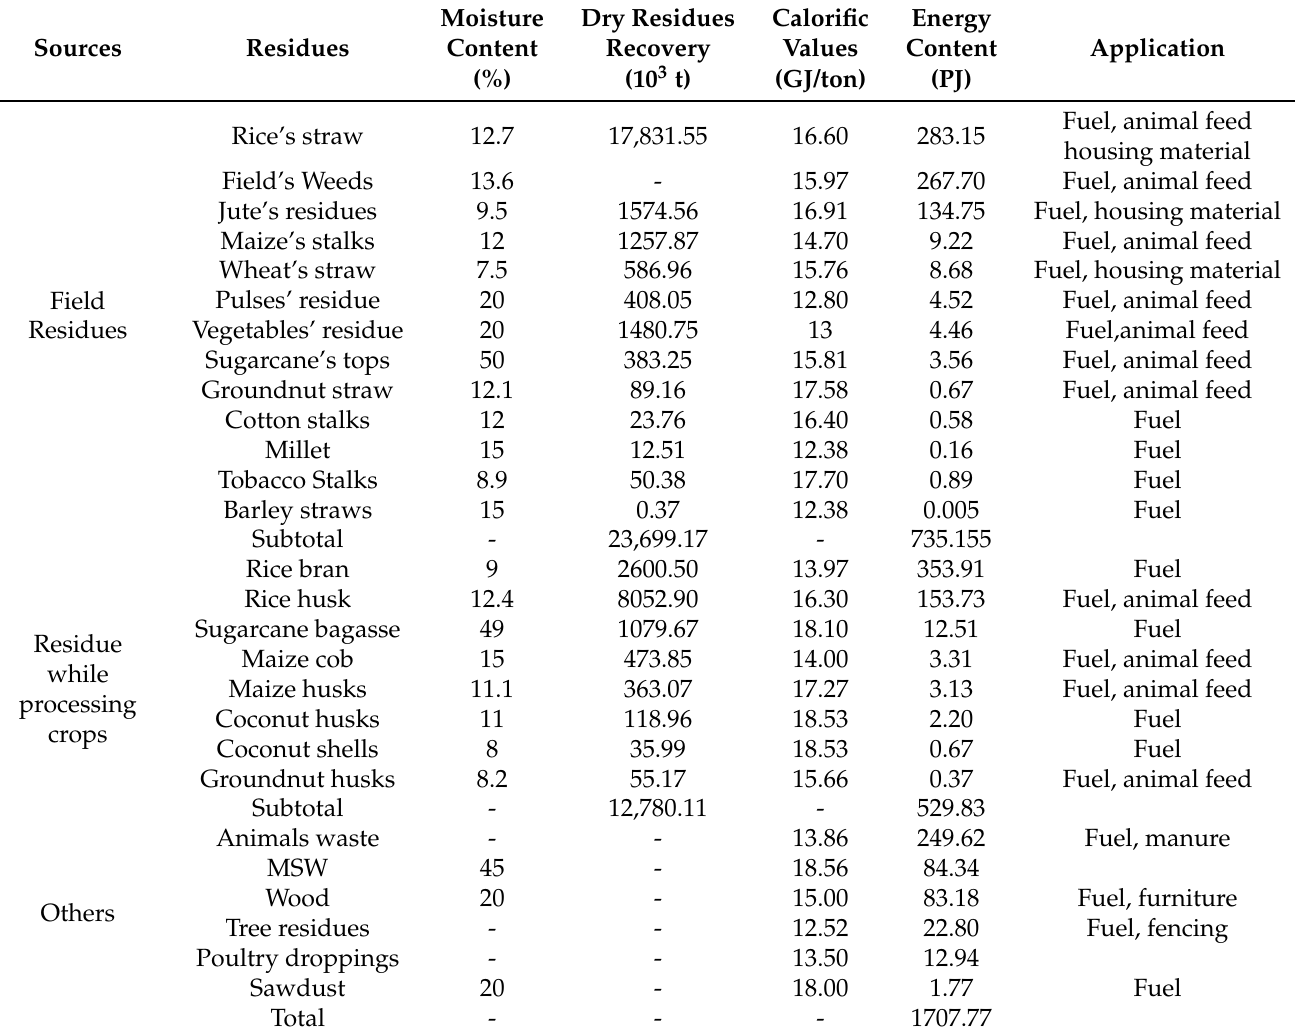
Table 4. Potential energy generation capacities from biomass residues